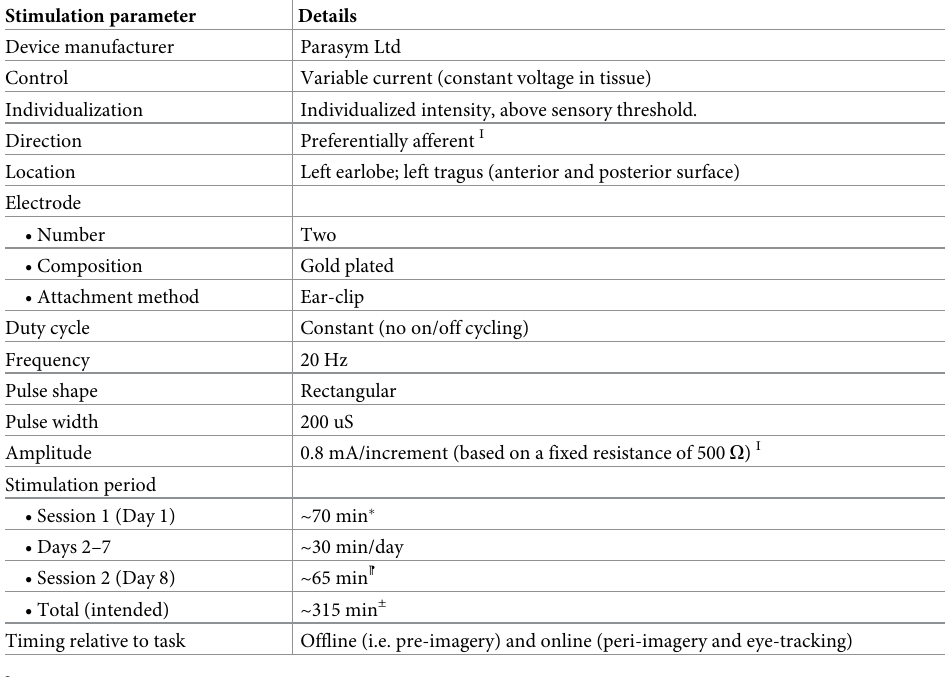
Table 1. Stimulation parameters in accordance with minimum reporting